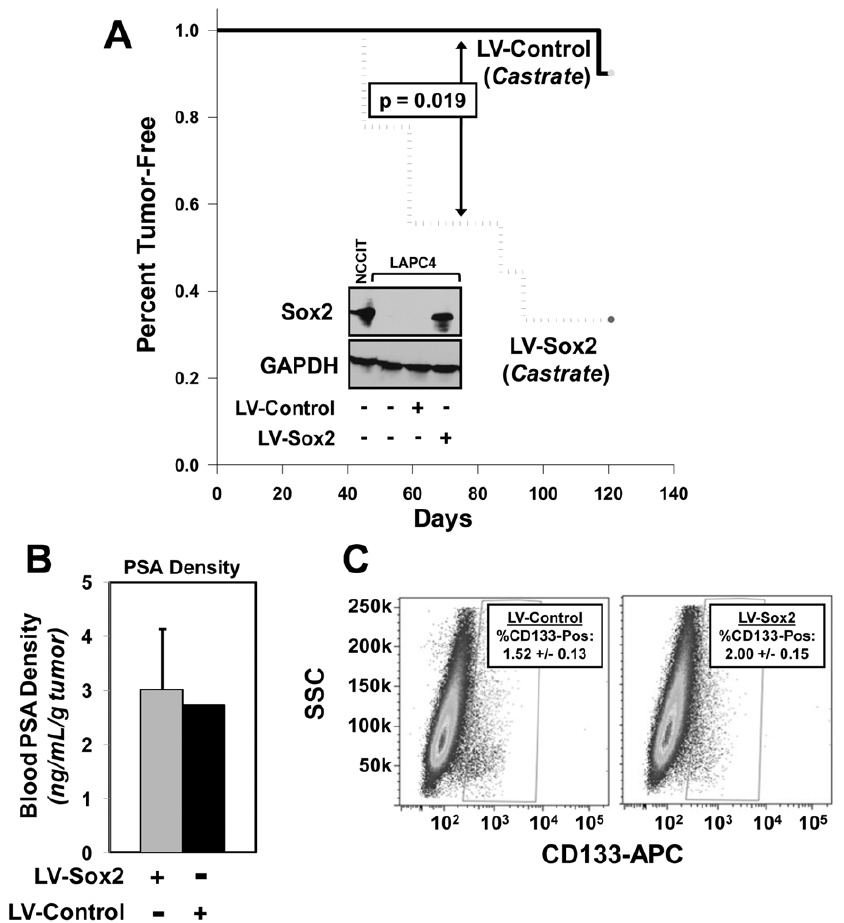
Figure 7. Sox2 expression promotes castration resistant prostate cancer tumor formation. A ) Ectopic expression of Sox2 in castrate- sensitive LAPC-4 (LV-Sox2, n=10 mice) cells is sufficient to promote tumor take in castrated male nude hosts compared to control mice (LV-Control, n=10) (p=0.019). Inset: western blot documenting ectopic lentiviral Sox2 expression in LAPC-4 cells. GAPDH was used as a loading control. NCCIT cells are used as a Sox2-positive control. B ) Castrated LAPC-4-Sox2 versus LAPC-4-Control tumors do not have differences in serum PSA density. These data support that Sox2 expression does not confer a less-differentiated tumor phenotype. PSA density is the ng/mL total PSA per gram tumor. C ) Expression of Sox2 in LAPC-4 does not significantly increase the percentage of rare CD133-positive cells, which are thought to be putative